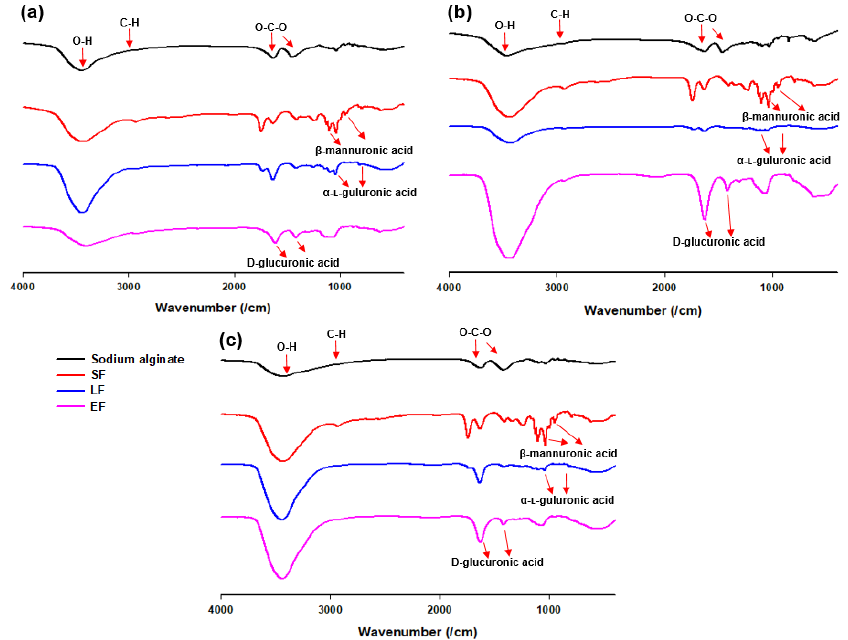
Figure 2. Fourier transform infrared (FT-IR) spectra of sodium alginate, solid fraction (SF), liquid fraction (LF), and ethanol fraction (EF) from ( a ) Sargassum fulvellum , ( b ) S. fusiforme, and ( c ) S. horneri.